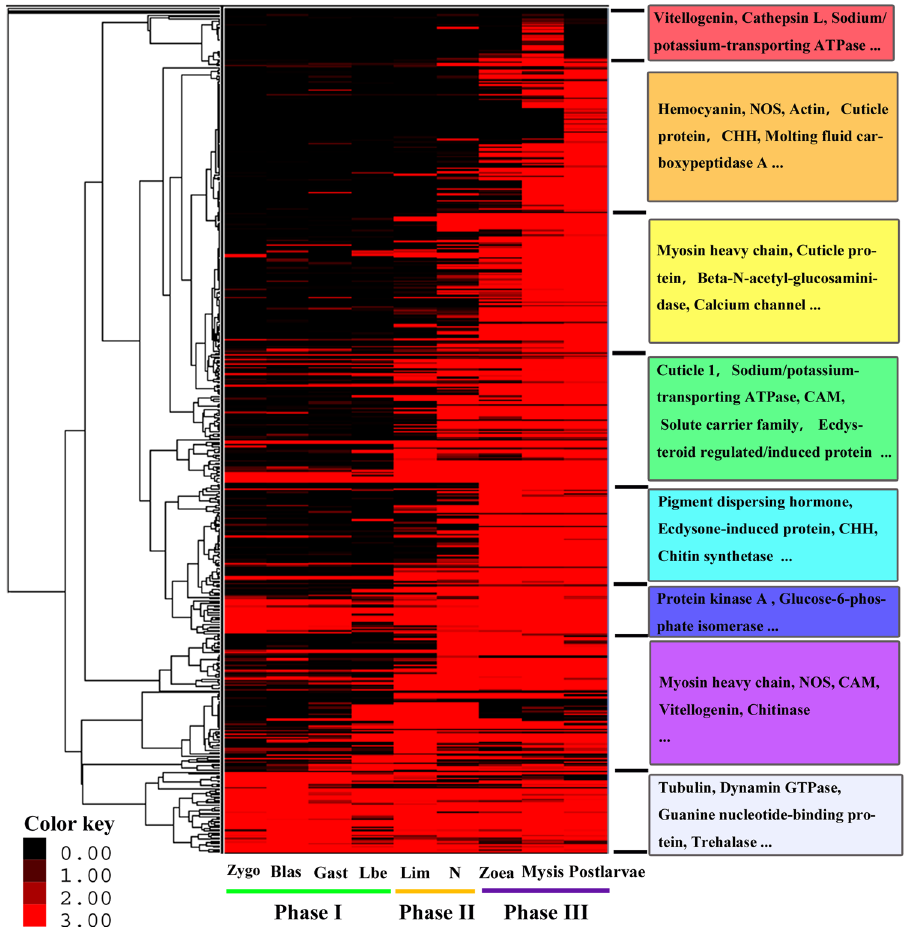
Figure 5. Hierarchical clustering of all exoskeleton-related genes. The clustering indicates similar expression patterns among the developmental stages (x-axis) and among the genes (y-axis). Colours represent the gene expression levels from black (low) to red (high). For each cluster, the major enriched genes are